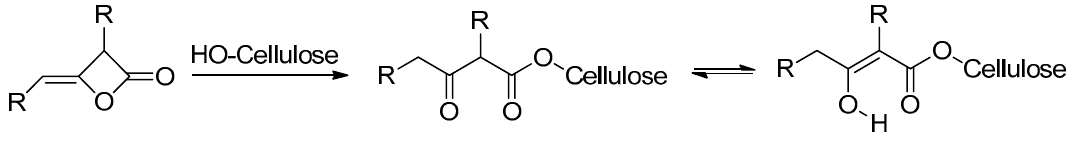
Table 2. Colour change (mean value) for both unmodified and thermally modified cedar wood samples after the AKD application. Means with the same letter are not significantly different from each other (p > 0.05 ANOVA followed by Duncan